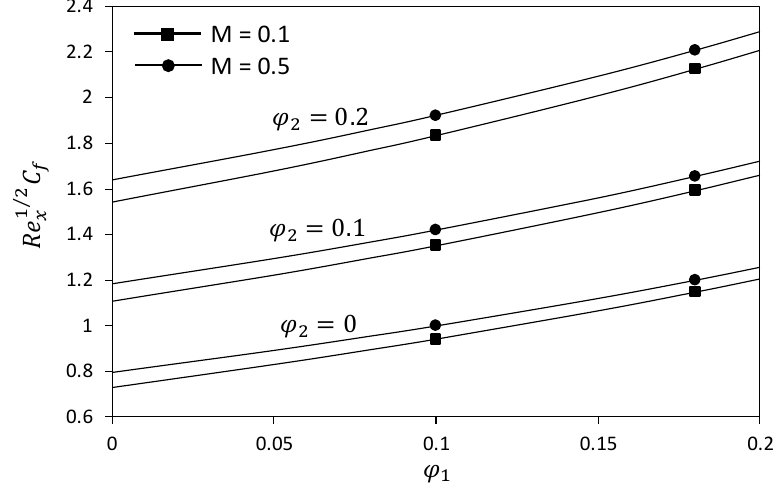
Figure 7. Re 1/2 x C f for some values of ϕ 2 and M